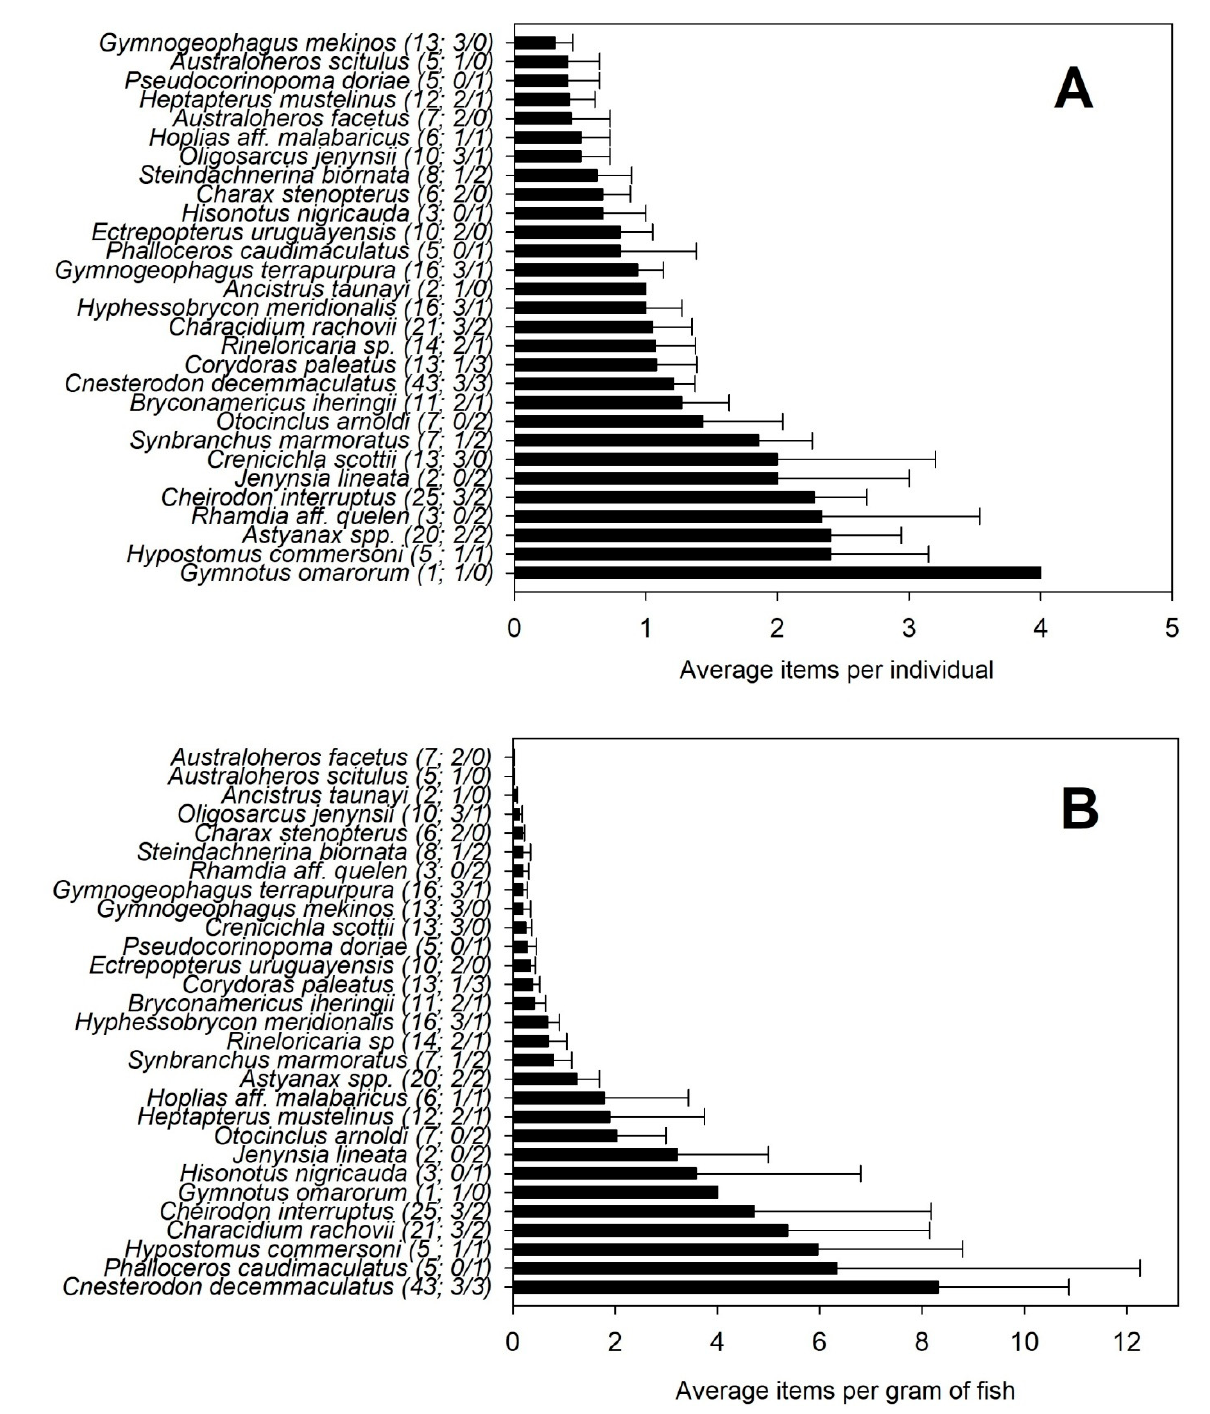
Figure 6. ( A ) Average of plastic items per individual per species, with its standard deviation. ( B ) Average of plastic itemsper gram of individual. Both graphs present the species in increasing order. In parentheses next to each species name, appears the amount of individuals analyzed, and secondly, how many sites within each group was the species collected, for Extensive Ranching and Urban streams respectively.